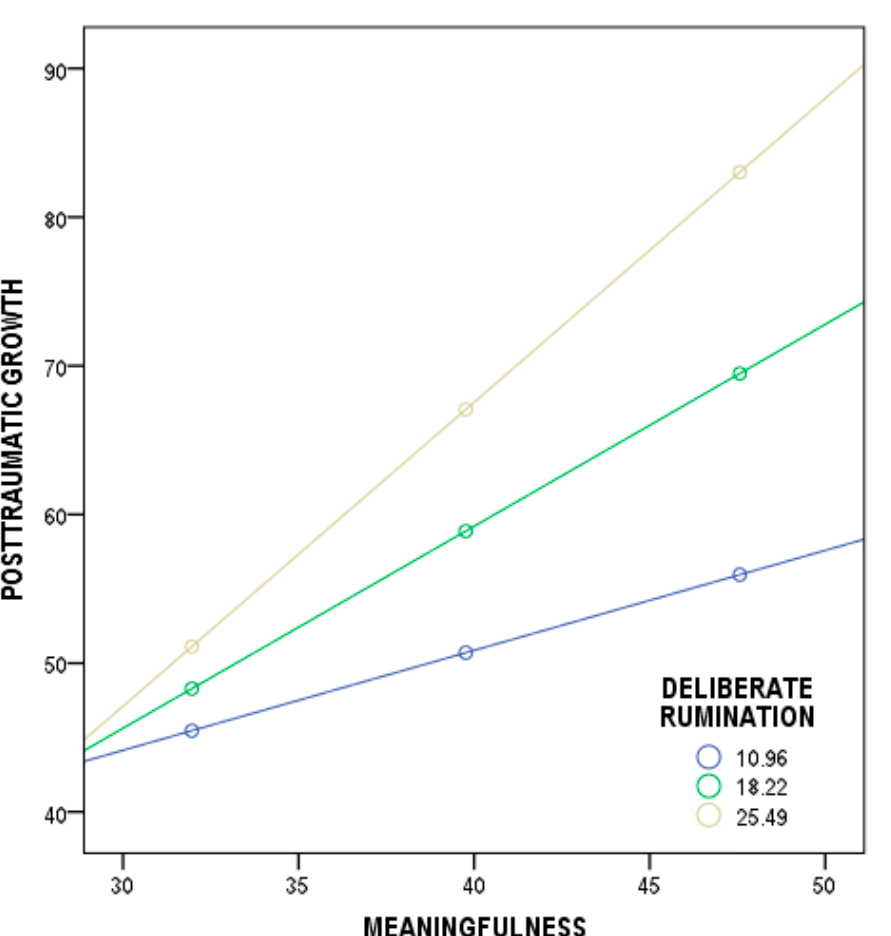
Figure 3. Plot of the slope analysis for the moderating effect of deliberate rumination in the relationship between meaningfulness and post-traumatic growth.